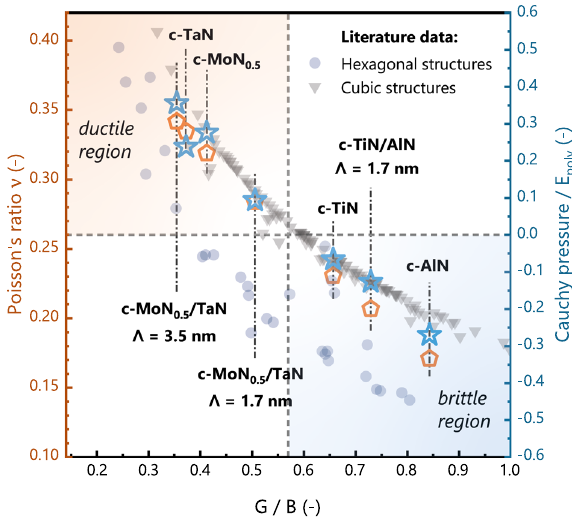
Fig. 1 Density functional theory studies describing the ductility. The Poisson ’ s ratio (according to the Frantsevich ’ s criterion: ν > 0.26 for ductile materials 62 ) as a function of the G / B ratio (according to Pugh ’ s criterion, G / B > 0.571 for ductile materials 63 ) is indicated by orange pentagons. The G / B dependence of the Cauchy pressure over the polycrystalline Young ’ s modulus ( CP / E > 0 for tough materials 64 ) is indicated with blue stars, gray triangles for literature data of cubic structures and blue circles for literature data of hexagonal structures. Our calculations are labeled using dotted – dashed lines. The ductile region is located at the left top corner (orange background), the brittle region at the bottom right corner (blue background). The dashed lines mark the various toughness criteria (the scale was chosen in a way that Frantsevich ’ s criterion and the criterion by Niu et al. 64 are on the same height). Exact values for literature data are given in Supplementary Table 1. Fig. 2 Cross-sectional SEM studies. The SEM-micrographs in ( a – c ) show